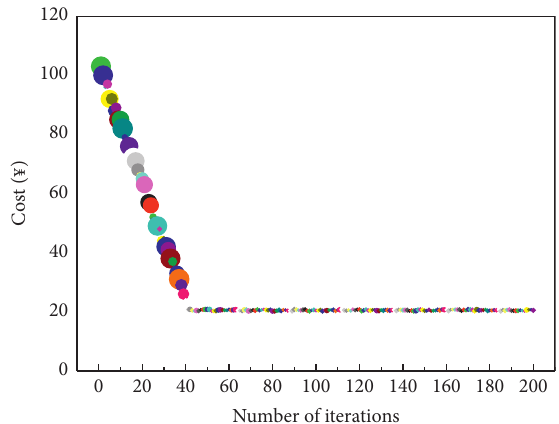
Figure 4: Iterative optimization process of genetic algorithm in collaborative optimization of logistics